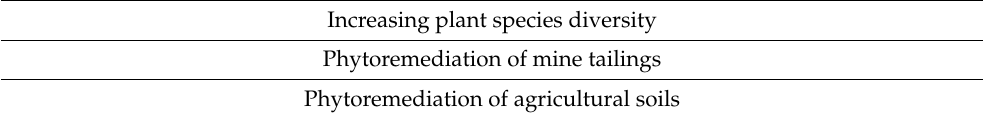
Table 2. Examples of the practical use of plant–microbe interactions in phytoremediation of